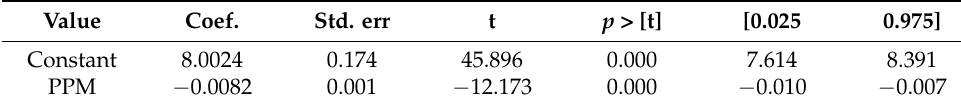
Table 2. OLS regression results (MQ2 continued).